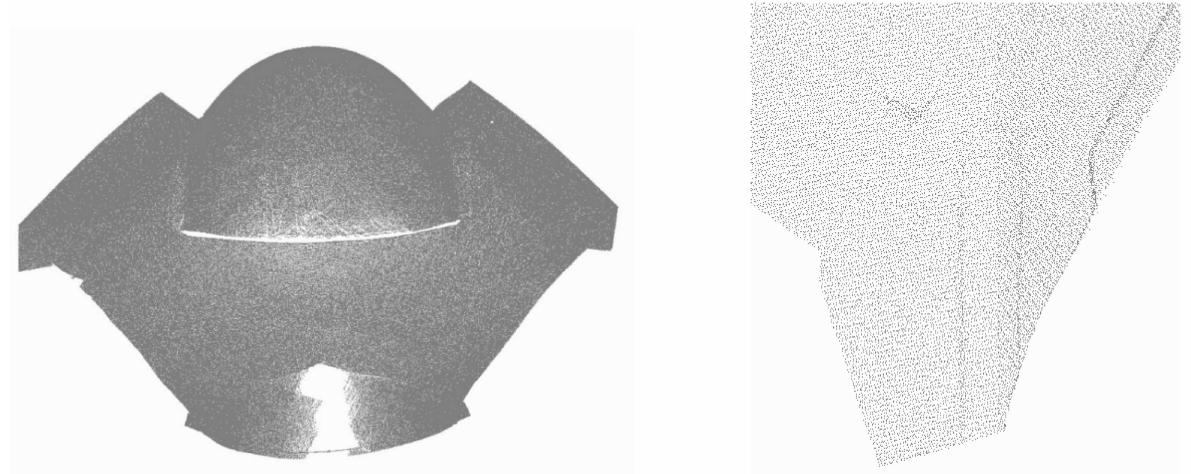
Figure 7. Point cloud of the structure and its fragment containing edges presented in Figure 6.